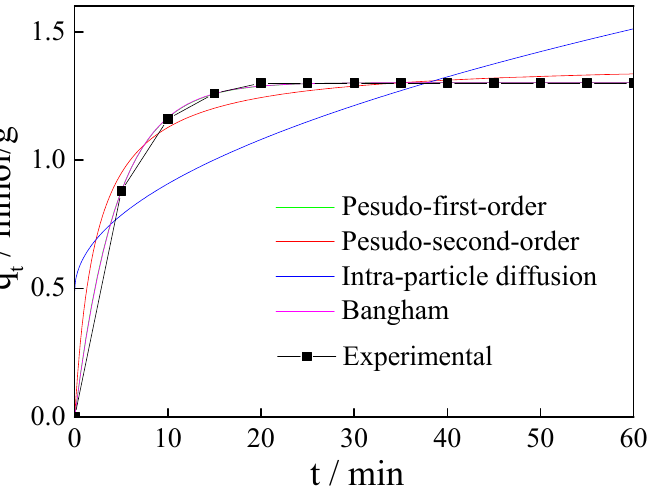
Figure 13. Adsorption kinetics of CO 2 on magnesite modified by [APMIM]Br under the conditions of 50 ◦ C, 0.4 MPa, gas flow rate 150 mL/min.